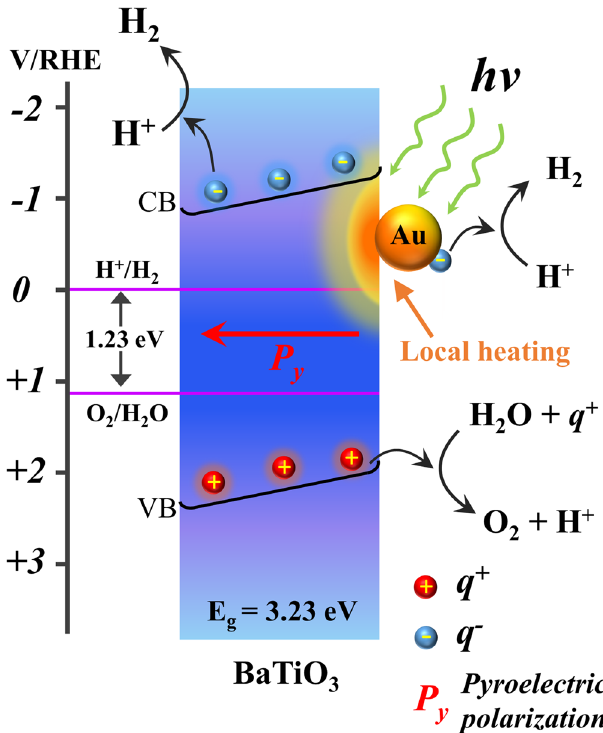
Fig. 5 | Pyro-catalytic mechanism. Schematic illustration of pyro-catalytic hydrogen generation of Au/BaTiO 3 NP driven by surface plasmon local